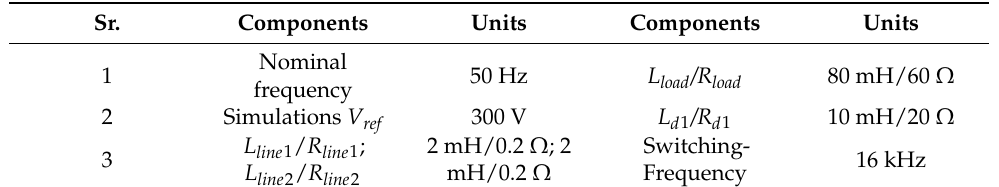
Table 2. System parameters for simulations.